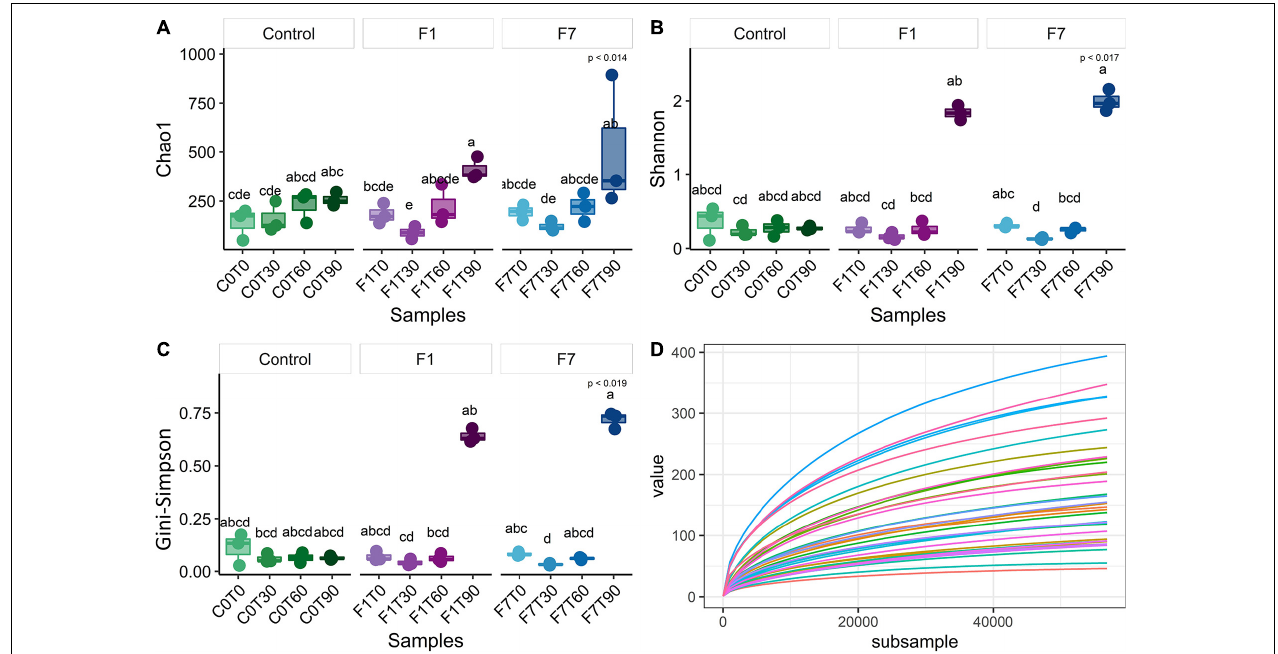
FIGURE 5 | (A) Chao1 index, (B) Shannon index, (C) Gini–Simpson index (1- λ ), and (D) rarefaction curves of observed species of fungal community composition. Each sample was rarefied at 56,830 counts, and the distribution of three biological replicates per sample is reported. Box and whiskers hinges represent first and third quartiles; upper and lower whiskers represent the furthest datapoints from median. Reported p -value is calculated by Kruskal–Wallis test ( α = 0.05). Group letters represent statistical significance at α = 0.05, based on Fisher LSD post-hoc test, with Benjamini–Hochberg correction for multiple comparisons: groups sharing one or more letters are not significantly